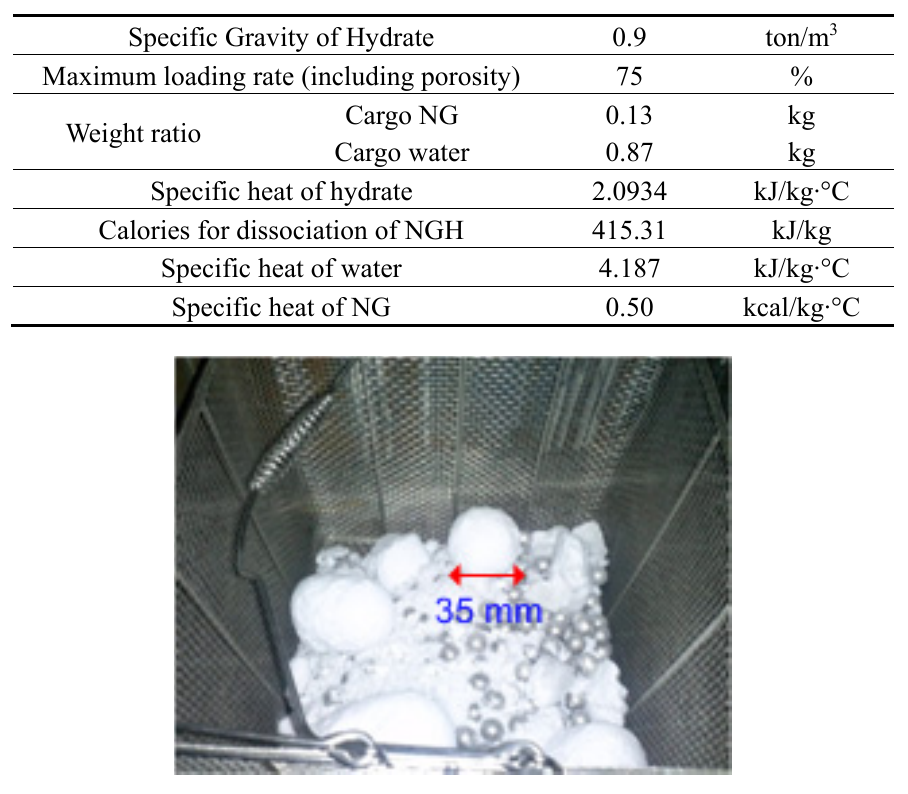
Table 2. Major assumptions and material properties for risk assessment in an NGH pellet carrier.